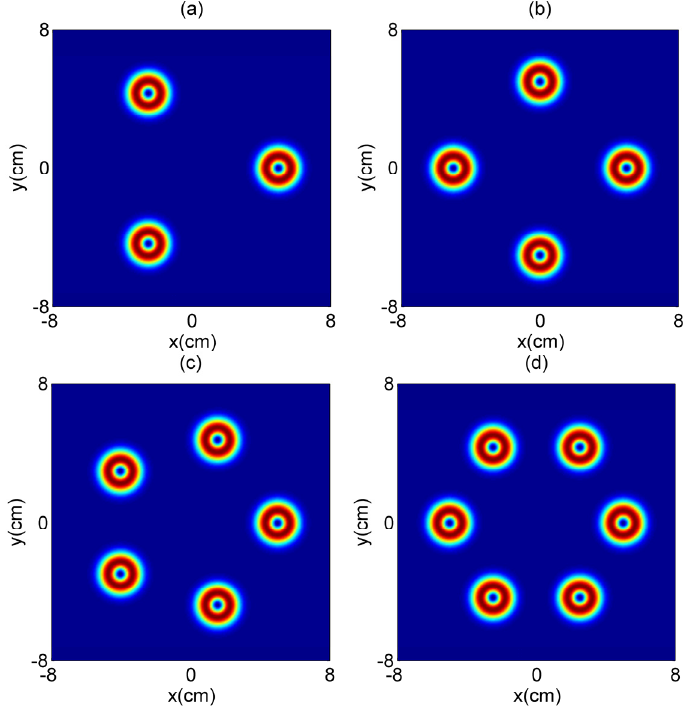
Figure 1. Normalized intensity of a RPLMGSMV beam array at z = 0 for the different Q . ( a ) Q = 3, ( b ) Q = 4, ( c ) Q = 5, ( d ) Q =